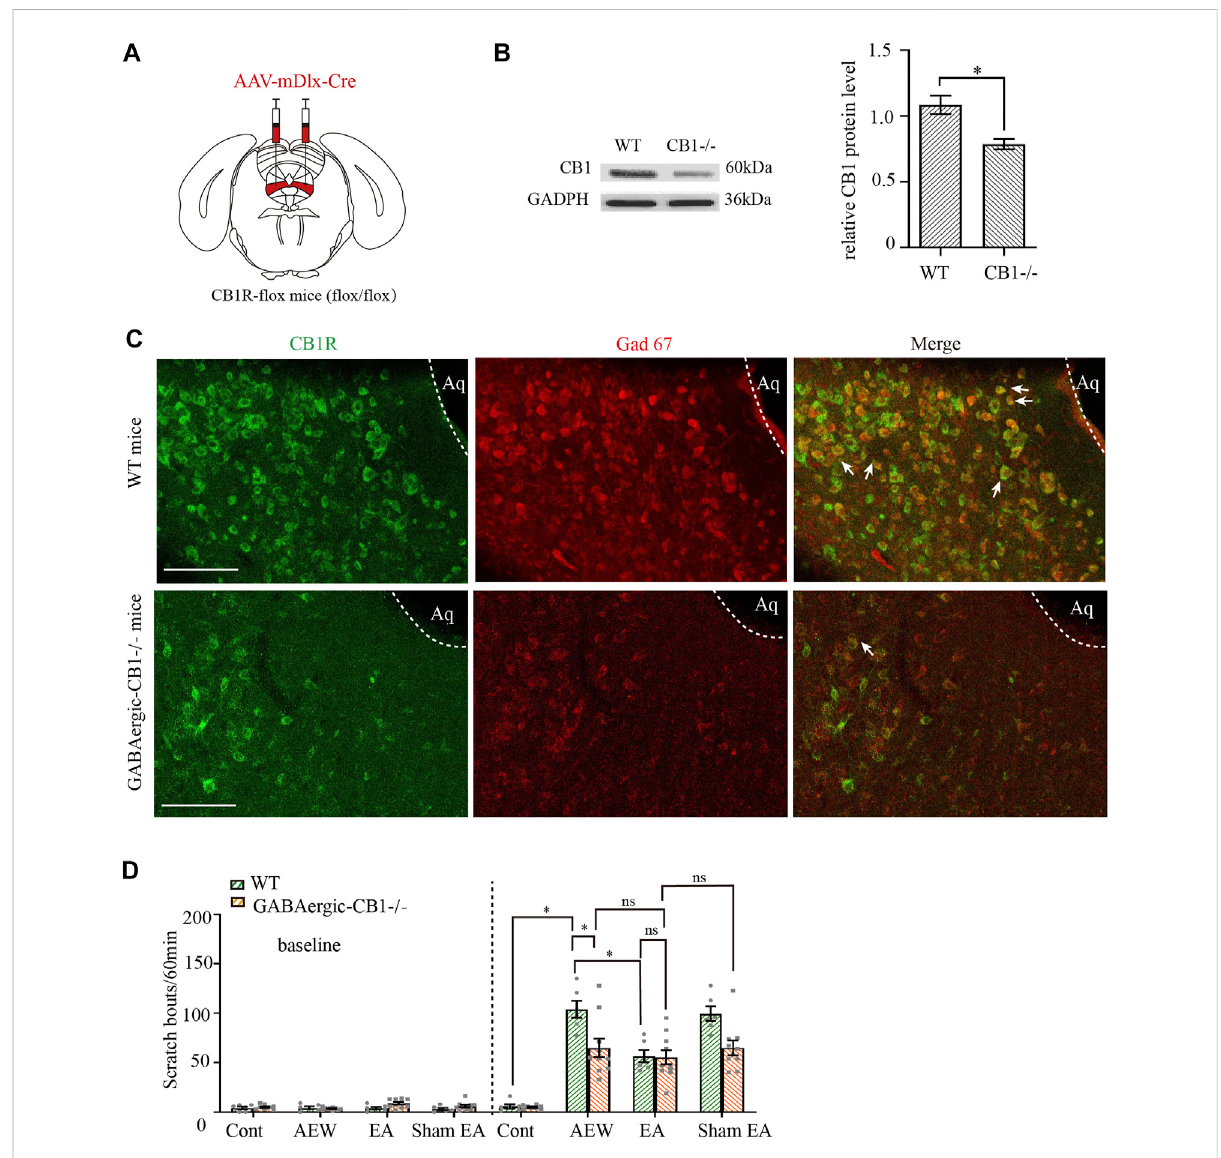
FIGURE 4 Comparison of the effects of EA on itch in control mice and GABAergic -CB1 − / − mice. (A) Schematic showing viral targeting of AAV2/9-mDlx- Cre transgenes bilaterally injected into the vlPAG. (B) Representative gel image (left) and quanti fi cation (right) of the protein level of CB1 receptors in wild-type mice and GABAergic -CB1 − / − mice. (C) Double staining of CB1 receptors (CB1R, green) and GAD67 mRNA (Gad 67, red) of the vlPAG in wild-type mice and GABAergic-CB1 − / − mice. (D) The comparison of scratch bouts in wild-type mice and GABAergic-CB1 − / − mice. Scale bars: 100 μ m. Data are expressed as means ± SEM ( n = 10 mice in GABAergic-CB1 − / − mice, n = 6 mice in wild type mice). * p <